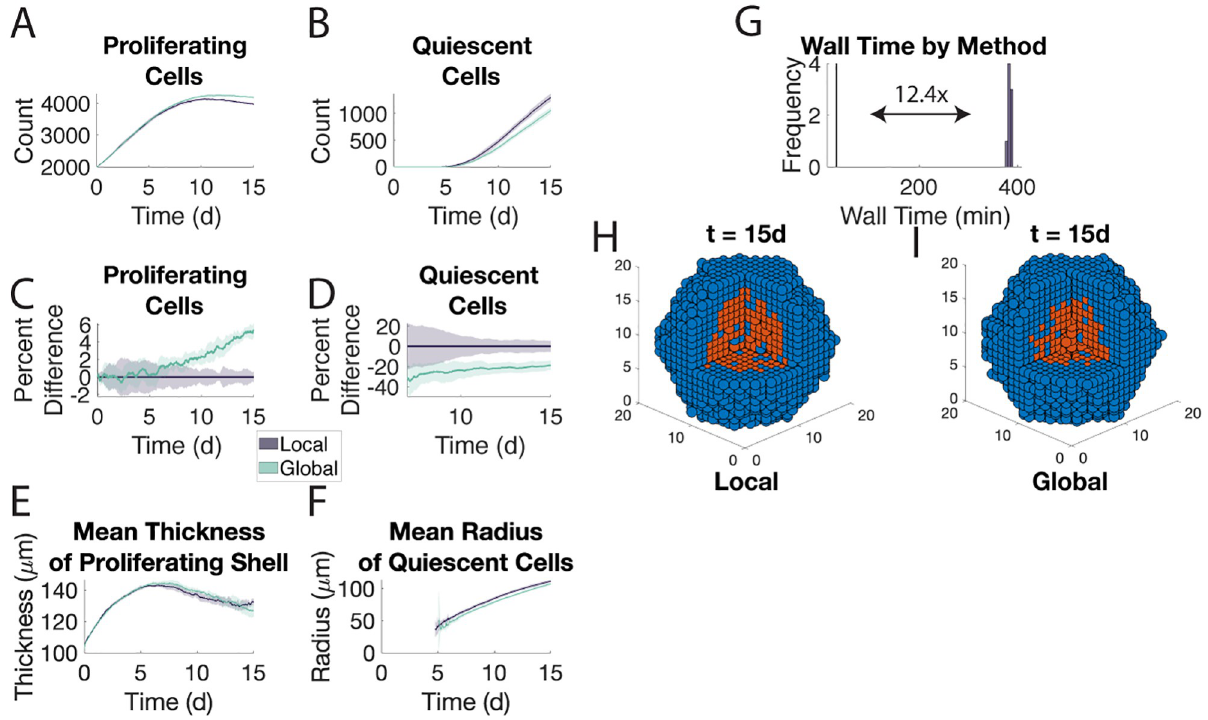
Fig 5. The global method agrees with the local method when vasculature surrounds the microenvironment in 3D. Eight samples of each method are shown. Direct Euler was used to solve the intracellular signaling ODE. See caption for Fig 2. E. Mean thickness of the proliferating shell. Measured by computing the difference in maximal and minimal distances of proliferating cells from the center of the microenvironment within each subset of a partition of the microenvironment and using a weighted average thereof. F. Mean distance of quiescent cells from the center of the microenvironment.